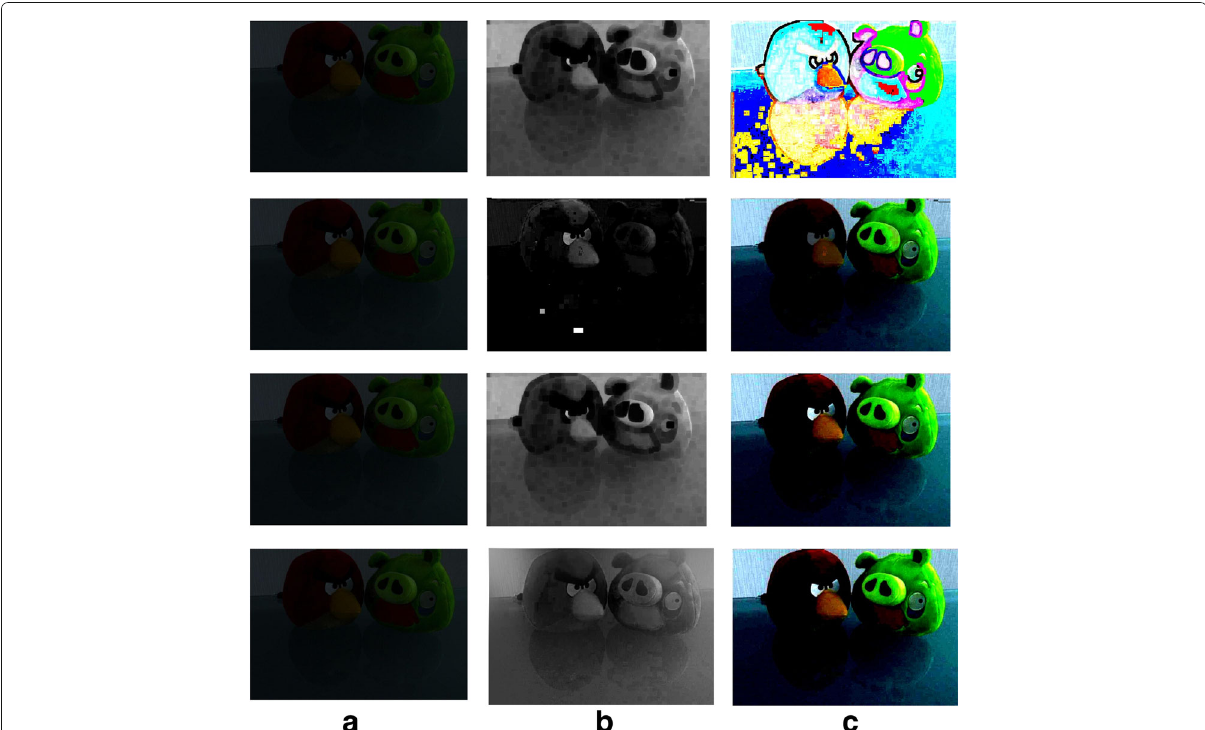
Fig. 17 Comparison of the effect of different transmission optimization methods on the recovered image quality. From top to bottom, non-optimized transmission, softmap-optimized transmission, bilateral filtering transmission , and guided filtering transmission. a Input image. b Transmission maps. c Recovered